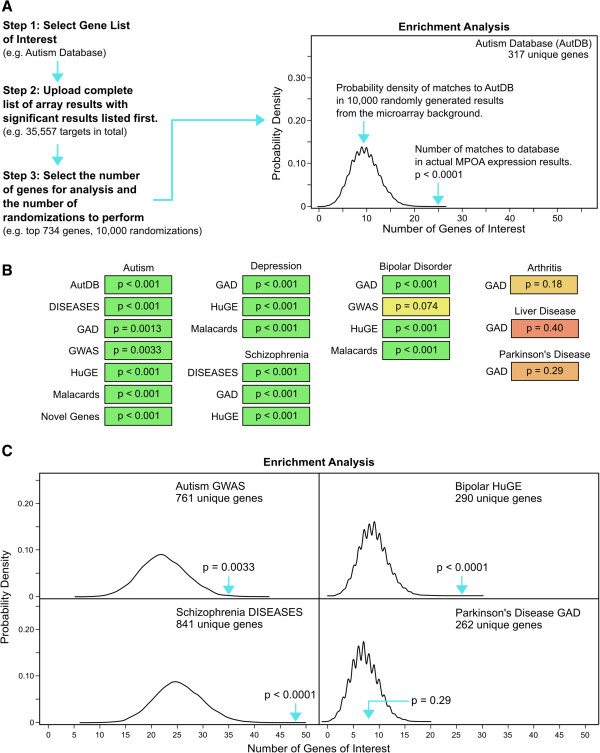
Overview of MSET procedure, and enrichment values for mental health disorder realted gene lists. (A) Overview of the MSET procedure with examples of gene lists selected for our analysis. After entering the desired number of randomizations to perform, a probability density distribution of matches to the gene list of interest is generated. The second blue arrow shows how many matches to the gene list of interest were found in our significant microarray results and the corresponding enrichment value. The y-axis represents the probability of matches between gene lists of interest and 10,000 randomly generated lists, and the x-axis denotes the number of genes of interest found in each randomly produced list. (B) Enrichment values for all gene lists tested relating to ASD, BPD, depression, and schizophrenia, and the control lists from GAD associated with arthritis, liver disease, and Parkinson’s disease. P-values were shaded based on their degree of significance, with green being the most significant and red being the least significant. MSET analysis detected overall enrichment for ASD, depression, and schizophrenia related genes in the top 734 genes from the microarray. Three of the four BPD associated gene lists revealed significant enrichment within the microarray results, but only a trend toward significance was found using the GWAS list. The control lists were non-significant, providing evidence for the specificity of MSET analysis. (C) Examples of the probability density distribution for four gene lists relating to ASD, BPD, schizophrenia, and Parkinson’s Disease. Arrows mark the number of genes of interest found in the top 734 genes from the microarray data.